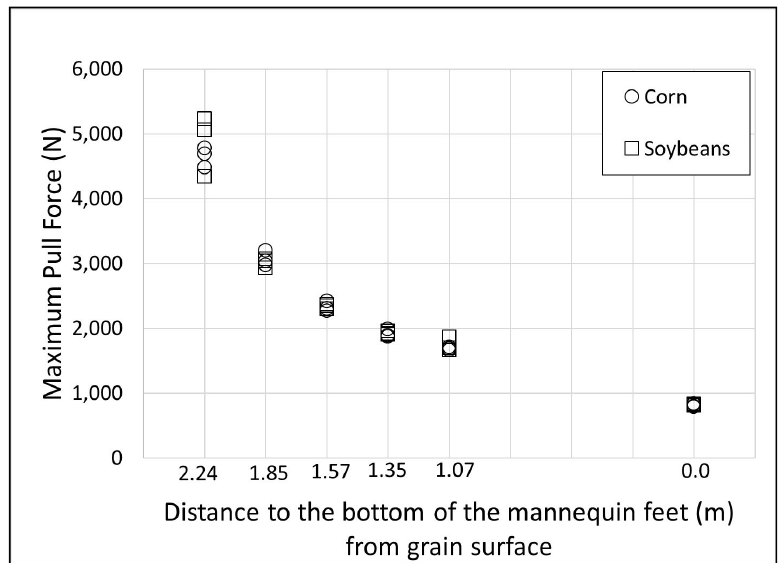
Figure 3. Maximum pull-force (in newtons) required to extricate the mannequin vertically at various depths in corn (circle) and soybeans (square). depths in corn (circle) and soybeans (square).